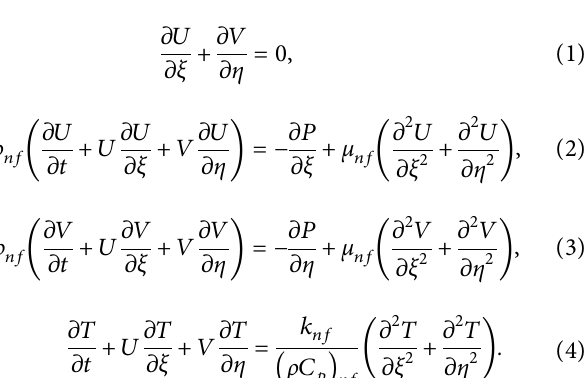
Figure 1: Geometry of the